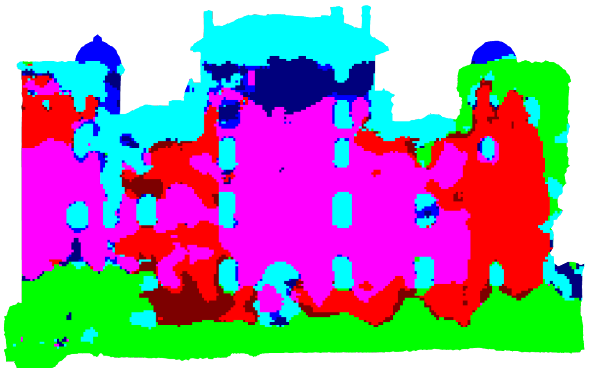
Figure 13. Confusion matrix related to the results of the classification results of figures